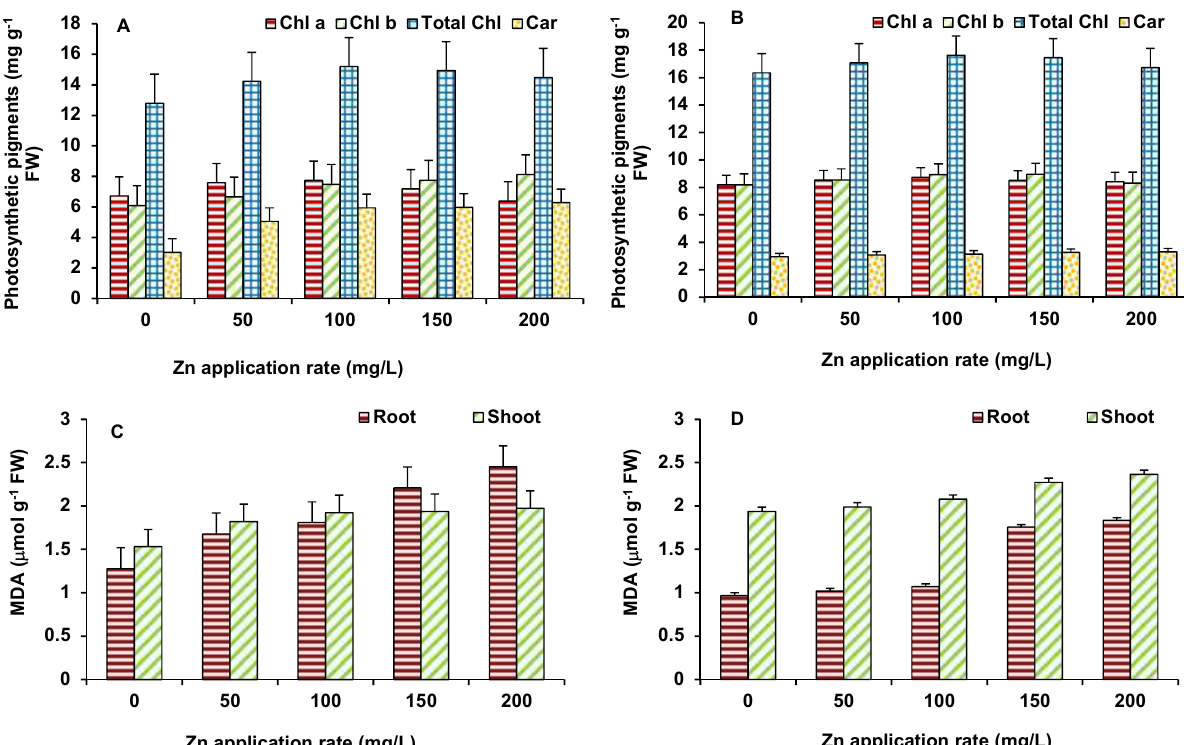
Figure 6. Effect of ZnO NPs treatment on photosynthetic pigments and MDA content of maize ( A , C ) and wheat ( B , D ). Values are means of four replicates. Error bars indicate the least significant value (LSD) at p ≤ 0.05 among the treatments.